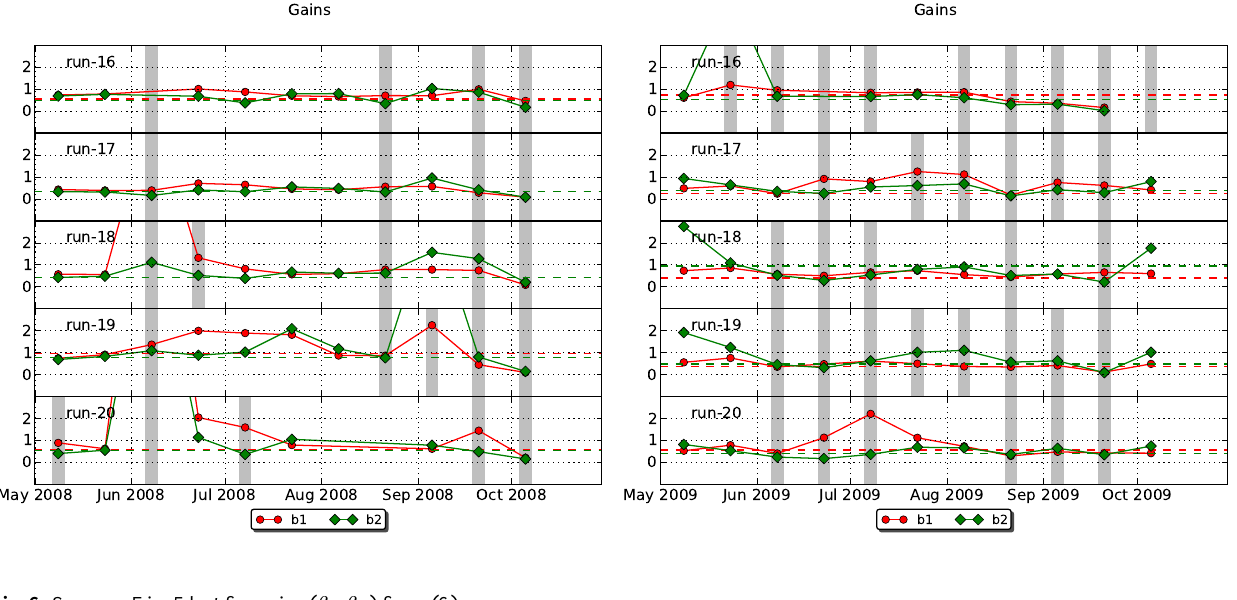
Fig. 6. Same as Fig. 5 but for gains ( β 1 , β 2 ) from